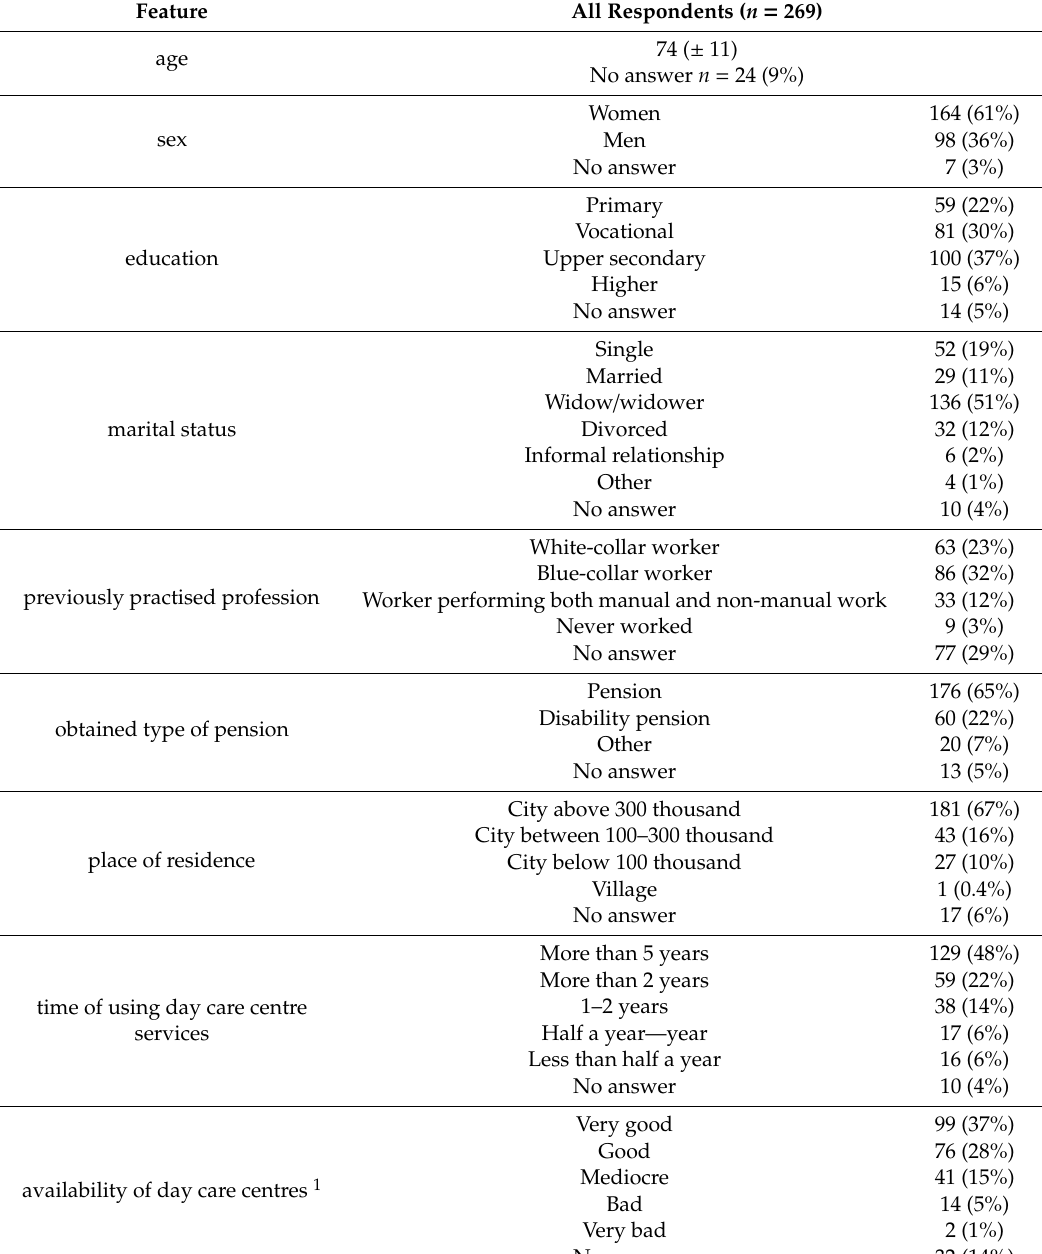
Table 1. Sociodemographic data of the attendees of day care centres in